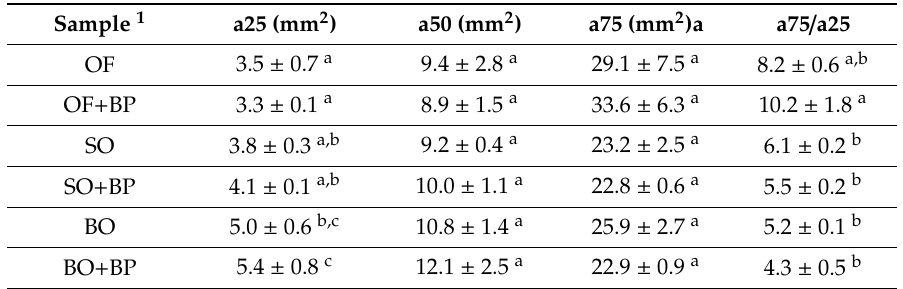
Table 2. Particle area for 25%, 50%, and 75% of the cumulative area and the a75 / a25 interquartile ratio of the biscuits after in vitro fragmentation.